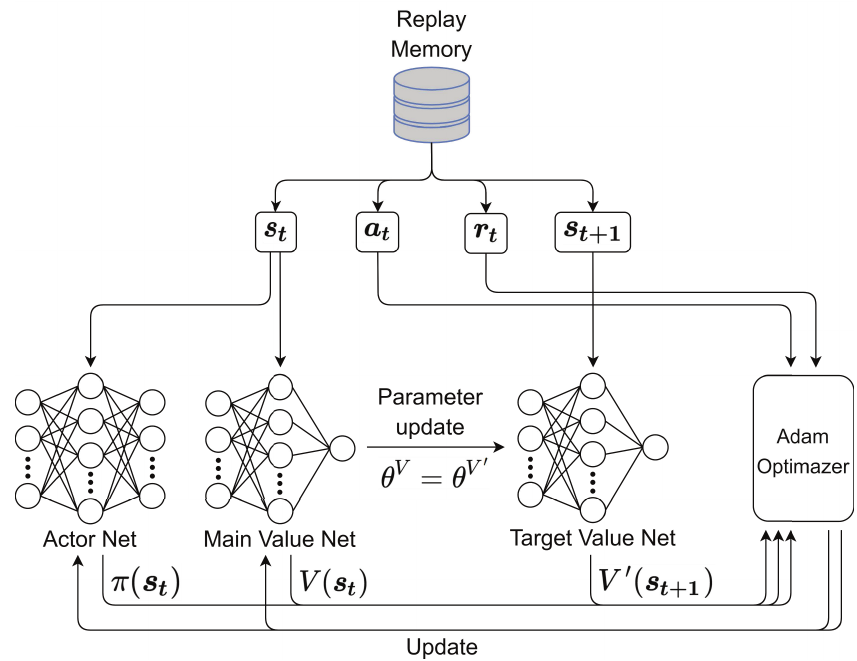
Figure 4. Illustration of the training process of the K